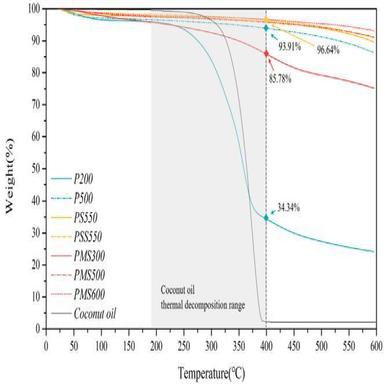
Thermal stability analysis of biochar and coconut oil.